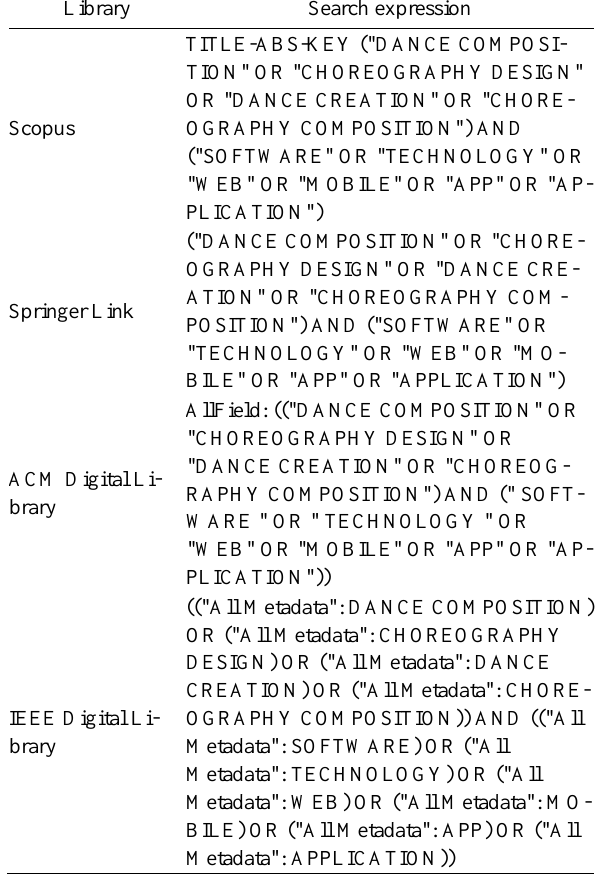
Table 1. Search expressions in digital libraries. Source: The